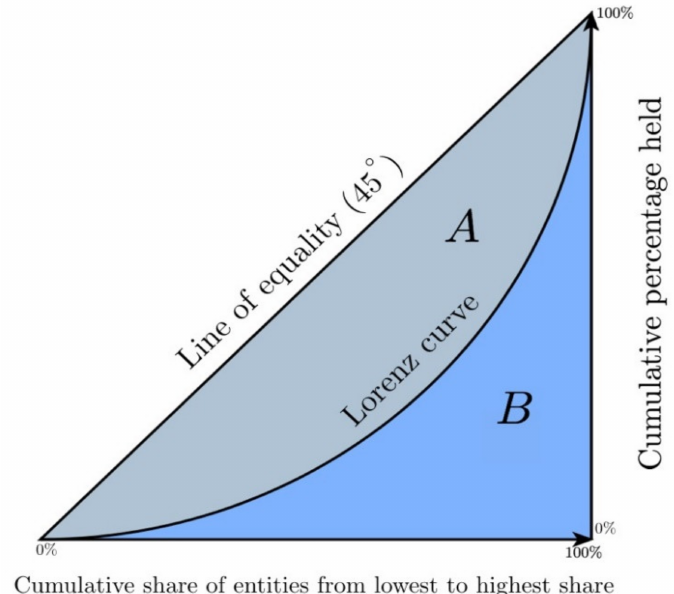
Figure 2. Graphical representation of the Lorentz curve and the Gini